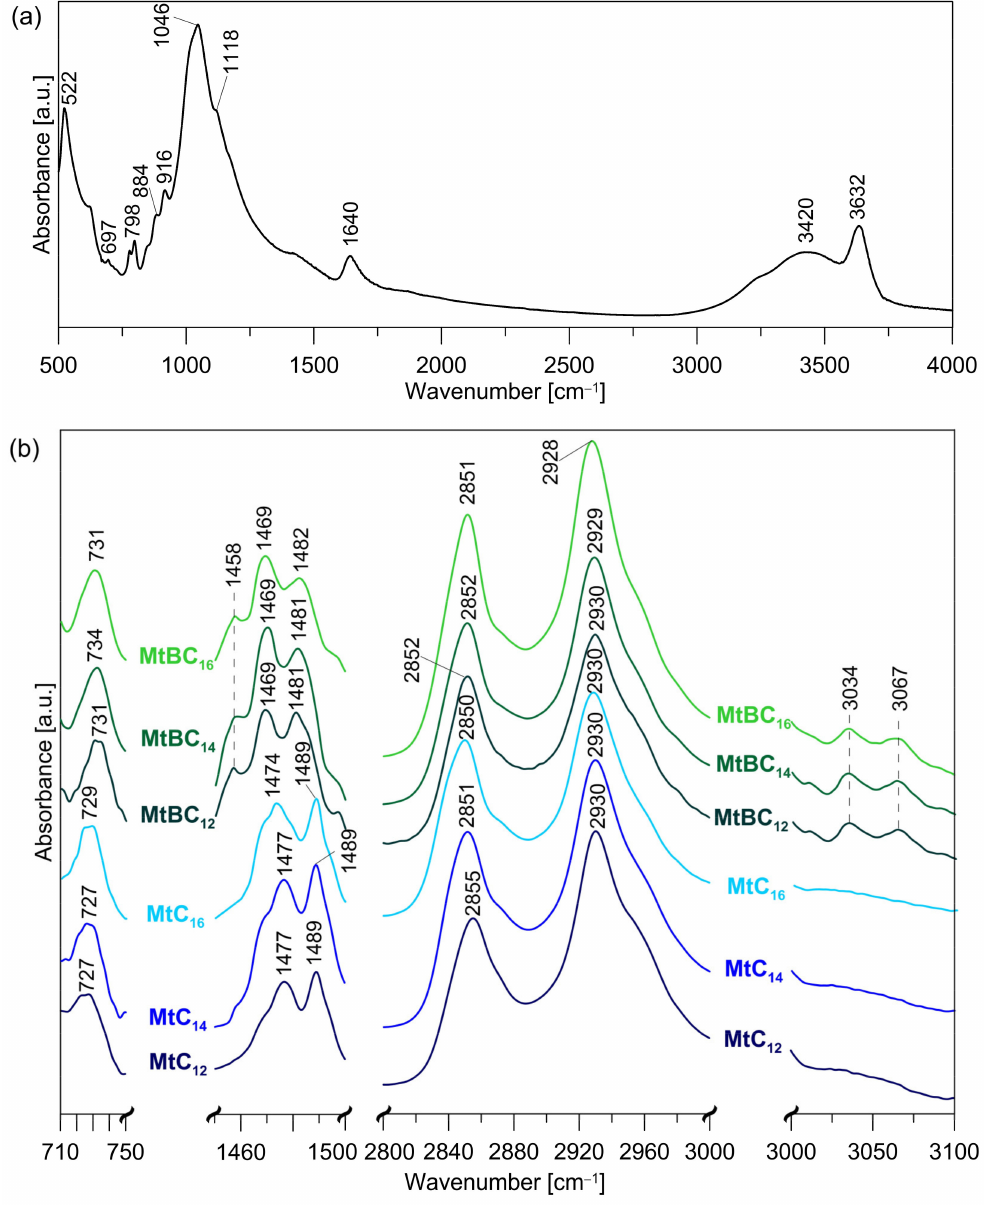
Figure 2. FTIR spectra: ( a ) raw montmorillonite; ( b ) montmorillonite intercalated with quaternary ammonium